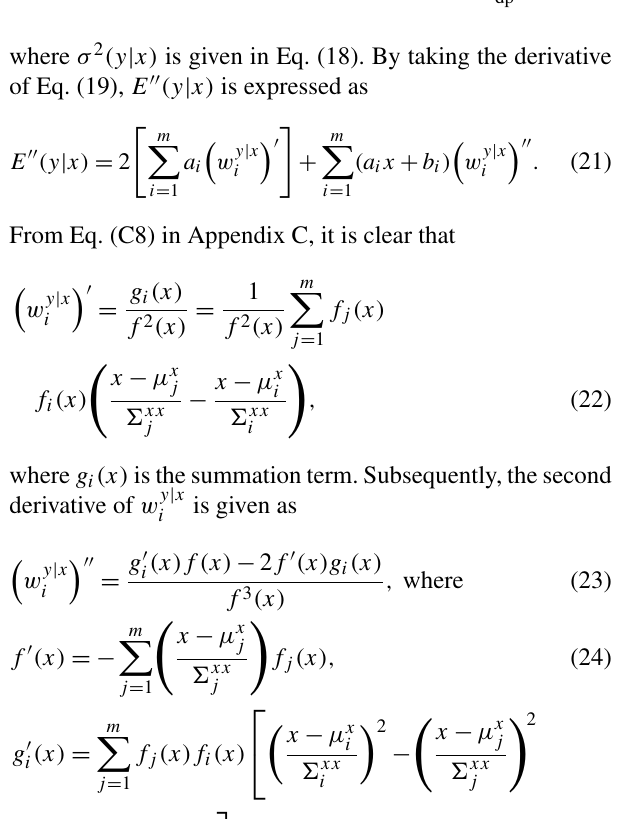
Figure 5. Flowchart of the (cid:57) dp unfolding and the δ co elimination. The µ 0 is the mean of the first density ellipse. The µ 1 and µ 2 are the means of the two consecutive density ellipses along the range. The µ 1 is the mean of the former one, and the µ 2 is the mean of the latter